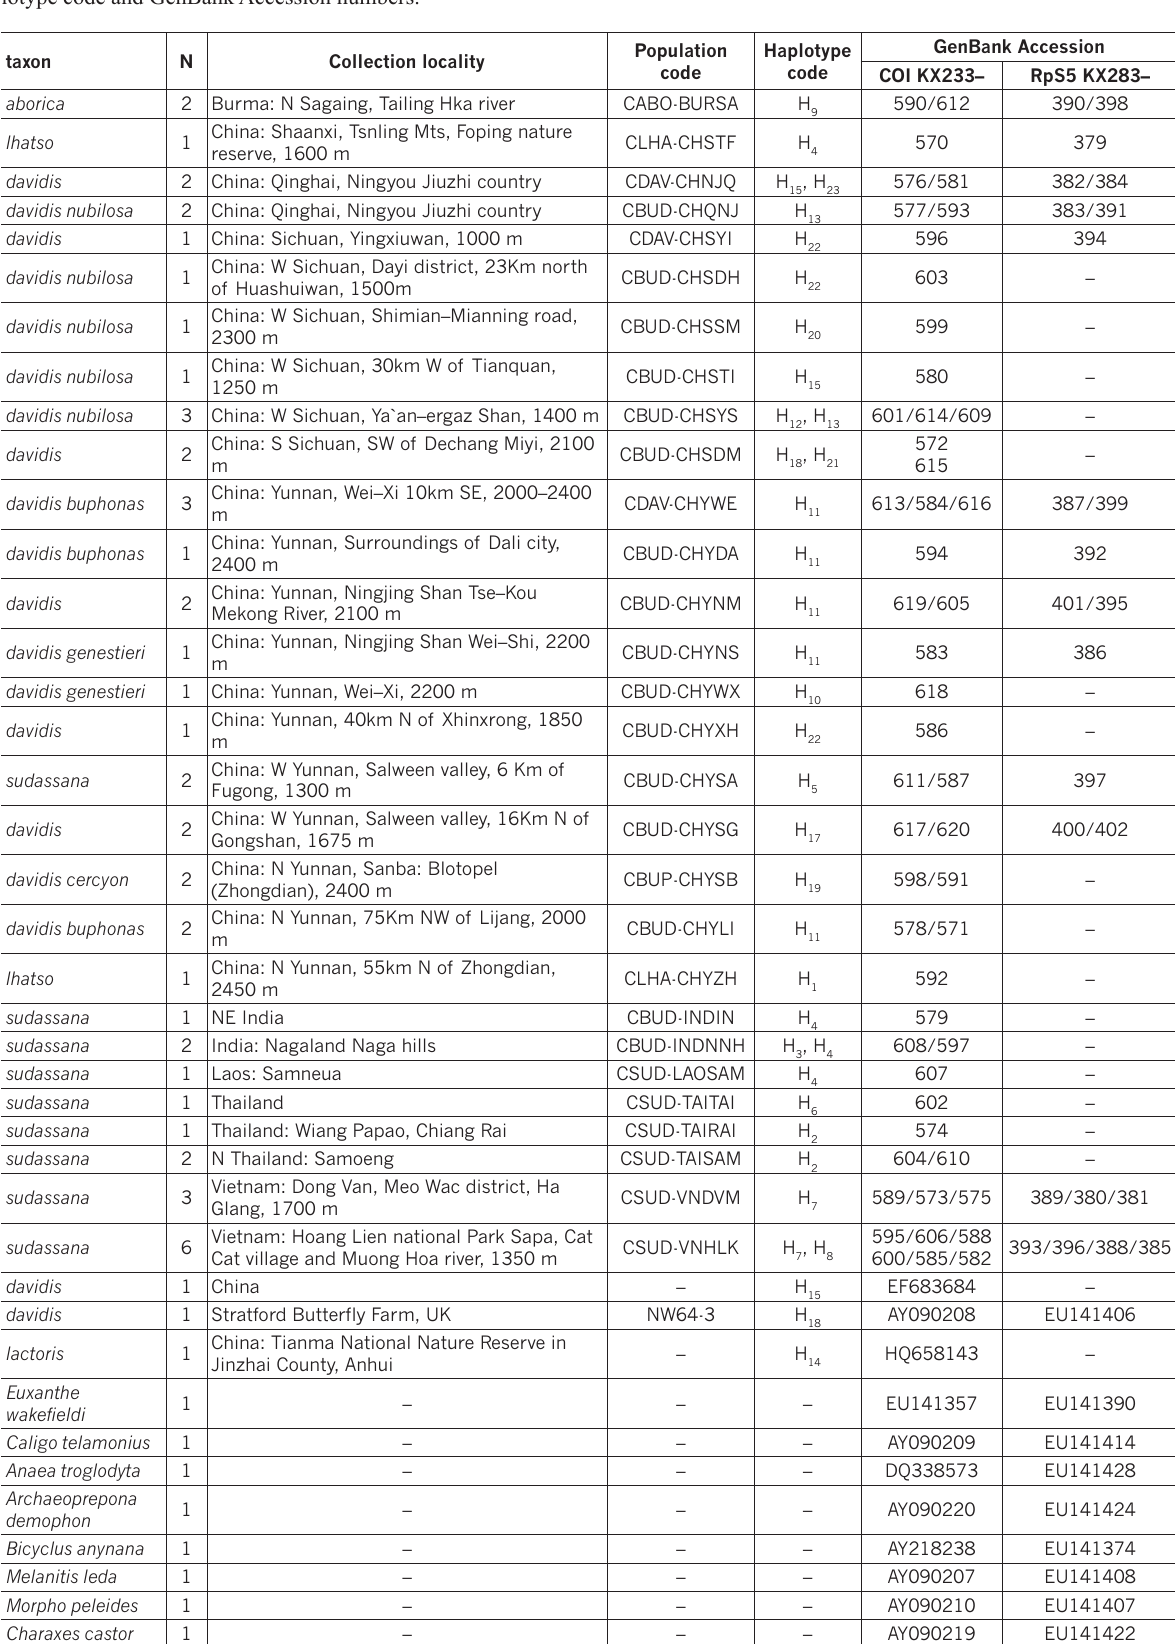
Table 1. Taxon= Calinaga species identified in this study. Sample numbers (N), collection locality, population code, mtDNA hap - lotype code and GenBank Accession